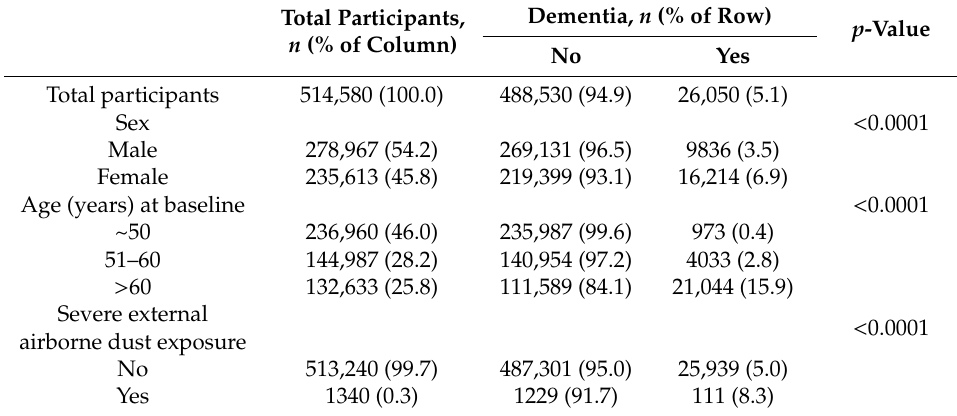
Table 1. Baseline characteristics of the National Health Insurance Service-Health Screening (2002–2015) participants according to